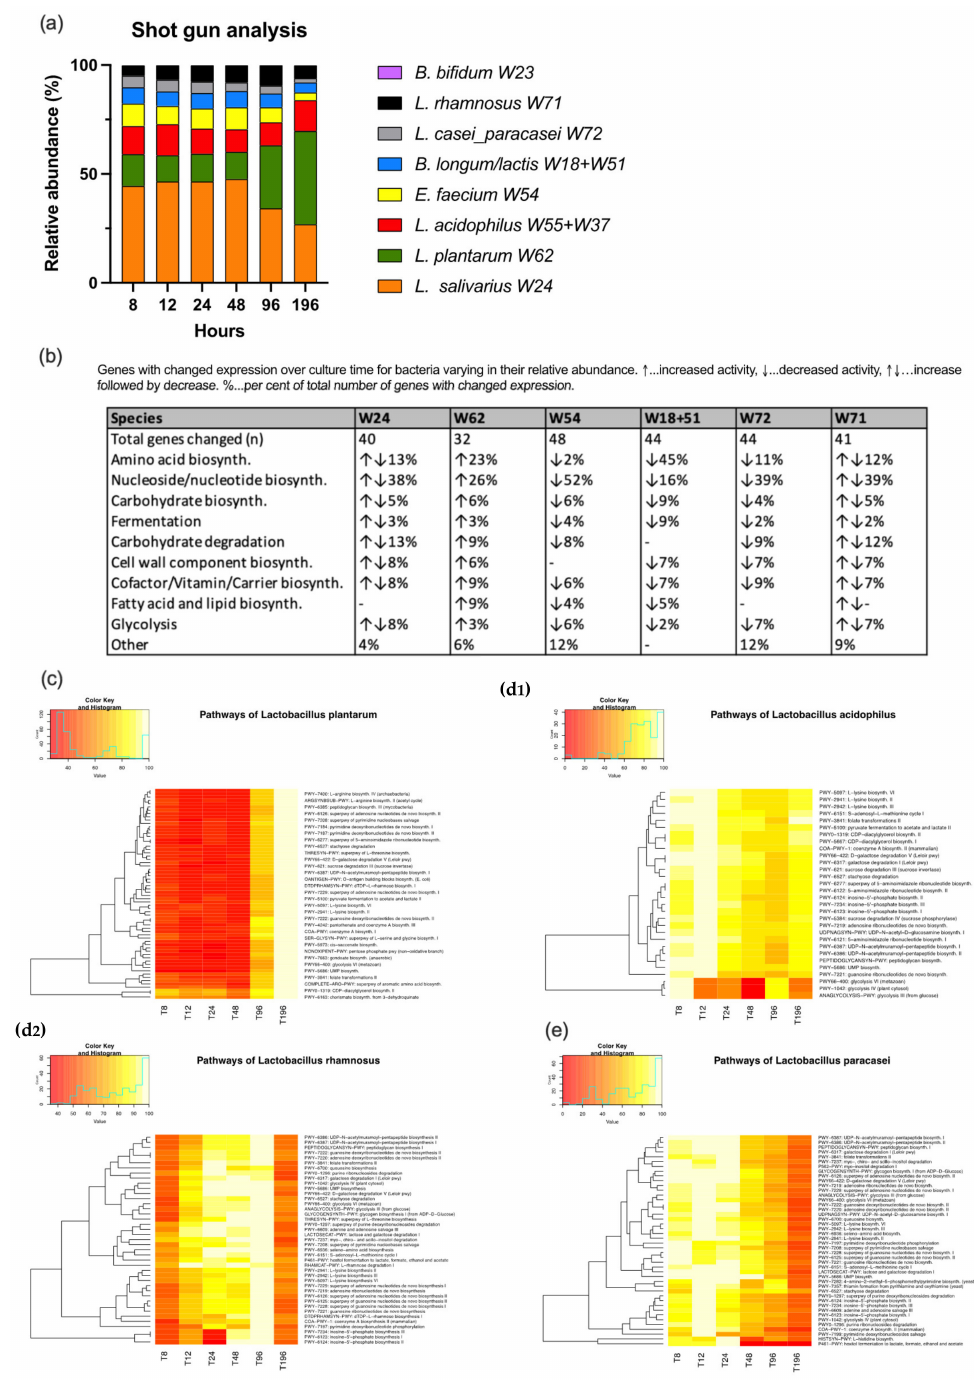
Figure 3. Shotgun analysis. Relative abundances ( a ); gene expressions of bacteria allocated to different pathways and change over time ( b ); heatmaps of selected bacteria ( c – e ). 0% of maximum colored in red and 100% in